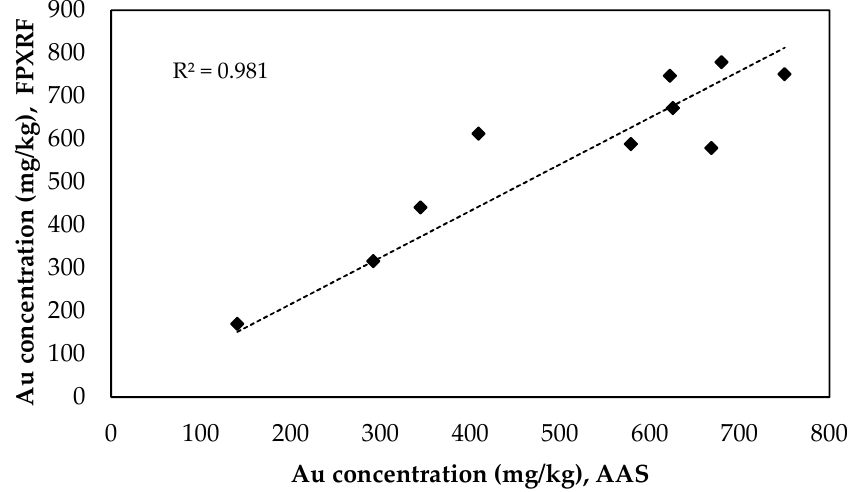
Figure 4. Regression of FPXRF and AAS concentration.